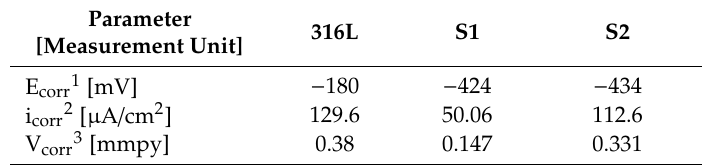
Figure 8. Polarization curves for 316L samples (S1, S2, and untreated 316L autoclaved) in 0.5M NaCl aqueous electrolyte. Table 5. Corrosion potential and corrosion rate as resulted from the Tafel slopes method.